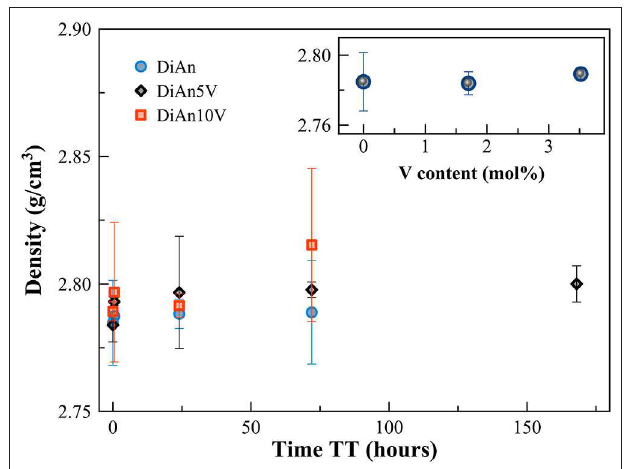
FIGURE 2 | Evolution of density with thermal treatment (TT) time for the pristine and V-doped DiAn glasses. In the inset, the density is reported against the V content